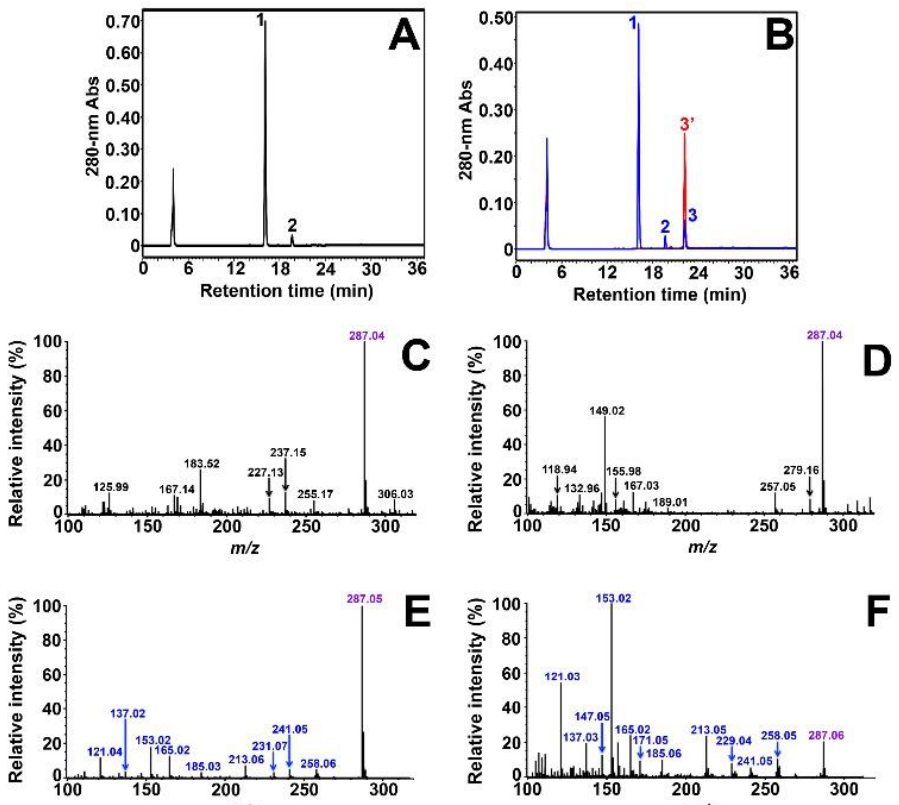
Figure 2. Characterization of Vv ANS product of (+)-DHK. (A) HPLC analysis of the commercial standard of 100 µM (+)-DHK in the reaction mixture without enzyme. (B) HPLC overlay chromatogram of the enzymatic degradation product of (+)-DHK (in blue) and the commercial standard of 100 µM kaempferol (in red). Peak 1 is residual (+)-DHK, peak 2 is the contaminant of commercial (+)-DHK, and peak 3 is the single enzymatic product of (+)-DHK. (C) MS analysis of collected peak 3. (D) MS spectrum of commercial kaempferol. (E) MS/MS fragmentation of the [M+H] + ion with m / z 287.04 observed in (C). (F) MS/MS spectrum of commercial kaempferol. The two minor peaks observed at 4 min in (A) and (B) correspond to ascorbate present in the reaction mixture as a cofactor of Vv ANS.